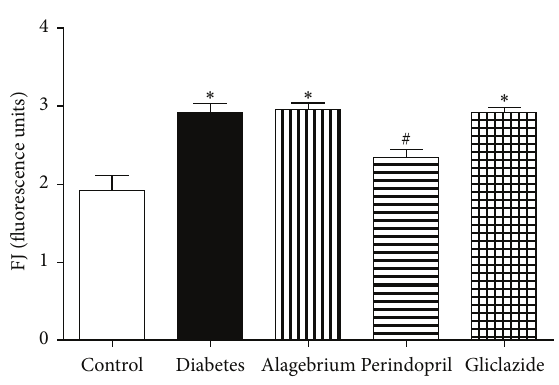
Figure 2: Effects of alagebrium (10mg/kg), perindopril (4 mg/kg), or gliclazide (10mg/kg) on neuronal degeneration (Fluoro-Jade fluorescence) in STZ-induced diabetes in rats. Data are presented as mean ± SEM ( 𝑛 = 6 ). ∗ Significantly different from control group. # Significantly different from diabetic group at 𝑃 < 0.05 using ANOVA followed by Tukey’s post hoc test.